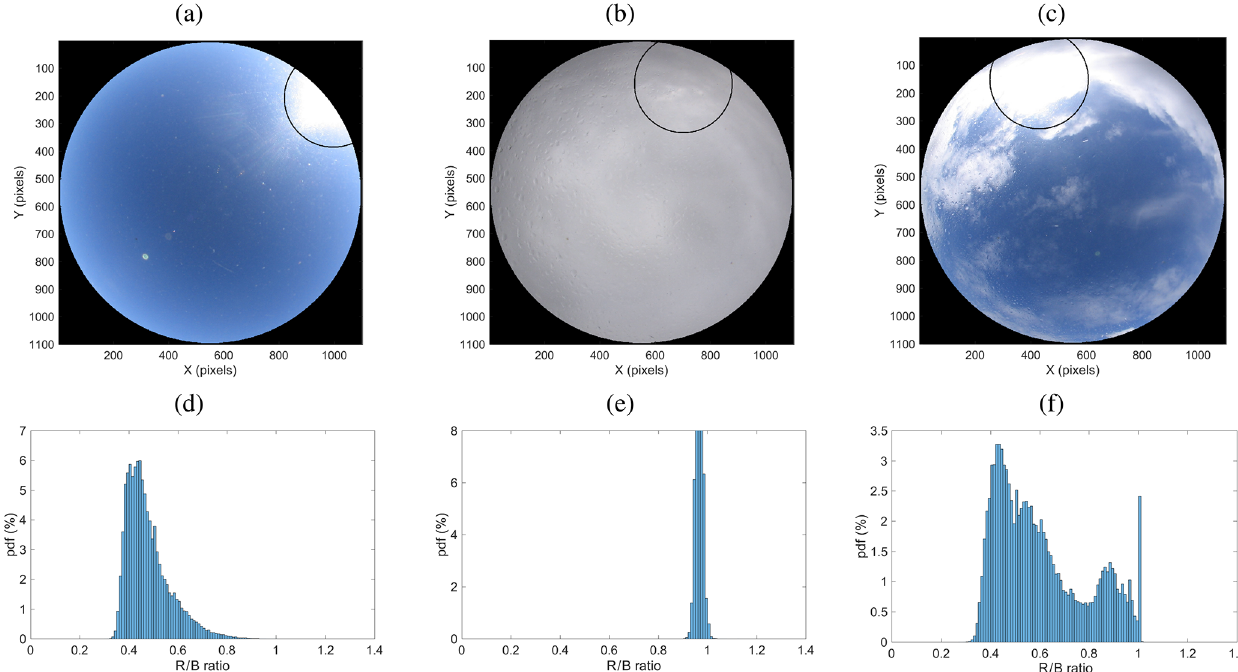
Figure 5. Cropped images of (a) 17 February 2014 at 08:30UTC, (b) 26 February 2014 at 11:00UTC, (c) 26 February 2014 at 13:00UTC, and (d, e, f) the corresponding PDF of the RBR,